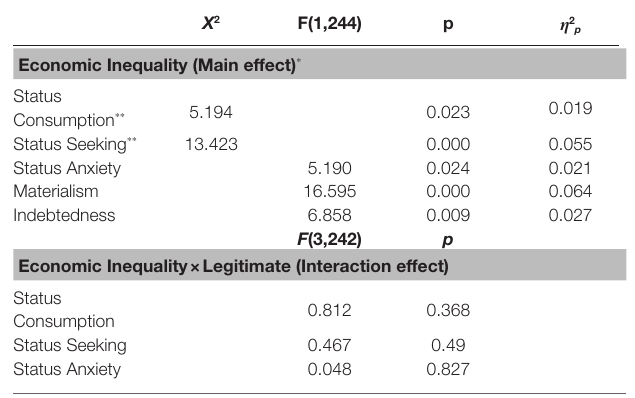
TABLE 2 | Multivariate analysis for the main effect of economic inequality (high/ low) and the interaction effect between economic inequality (high/low) and Legitimate (legitimacy/illegitimacy) on variables included in Study